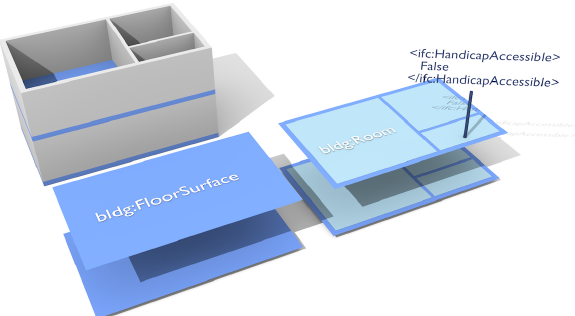
Figure 1. Overview of the project: we generate floor plans in CityGML in multiple variants (bottom and right) of the newly introduced LoD0 proposal by sourcing them from Building Information Model (BIM) data (top left) and preserving certain attributes not natively supported by CityGML but potentially useful for certain use cases. To support this process, we